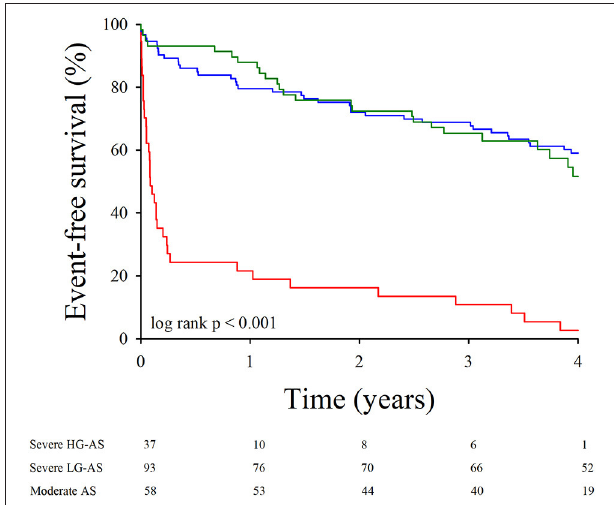
FIGURE 3 | Event-free survival according to baseline AS severity. Kaplan-Meier survival curves for the combined end-point of death and need for aortic valve replacement in patients with severe HG-AS in red, severe paradoxical LG-AS in dark green and moderate AS in dark blue.